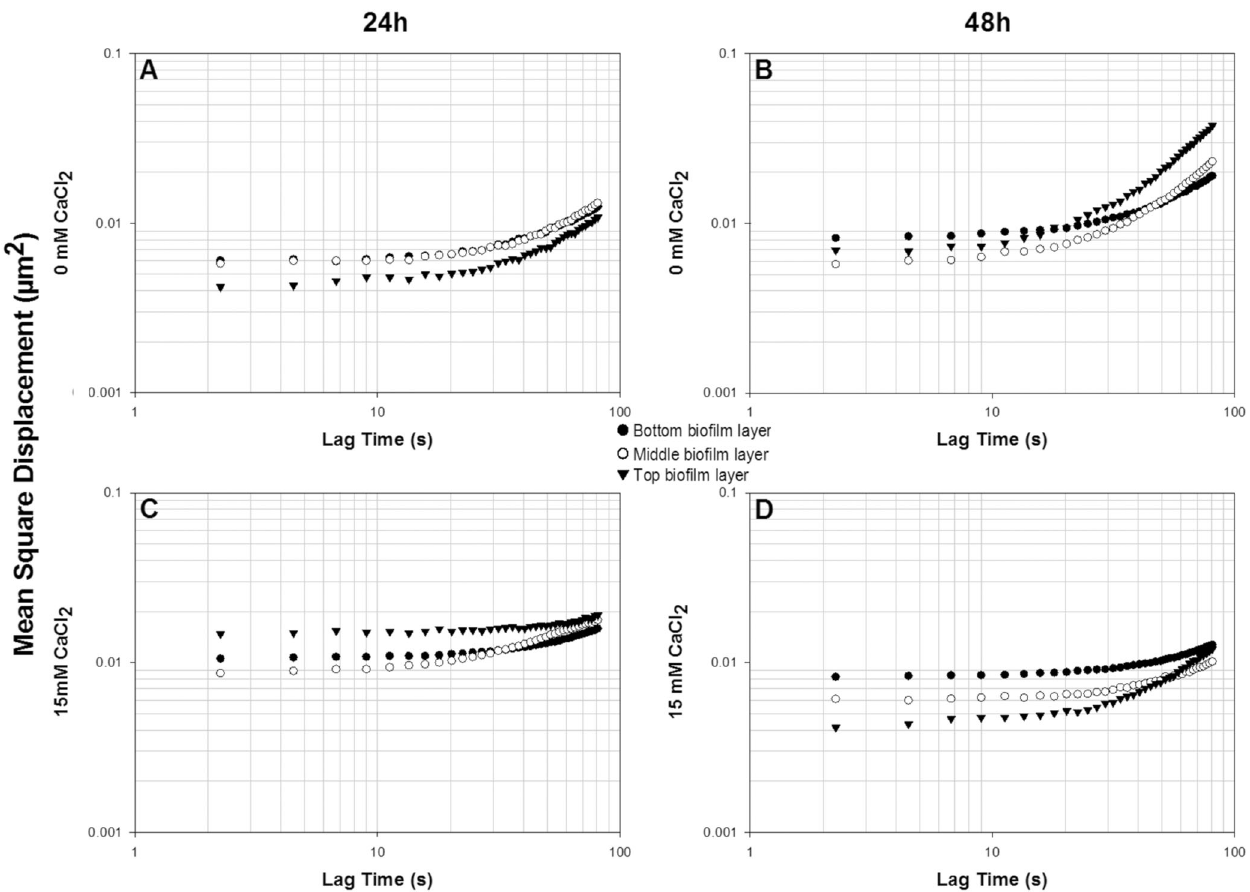
Fig. 3. MSD pro fi les of 1 μ m fl uorescent beads within bottom, middle and top bio fi lm layers of 24 h ( a , c ) and 48 h ( b , d ) Pseudomonas fl uorescens bio fi lms grown at 0 mM ( a , b ) and 15 mM ( c , d ) CaCl 2 environments